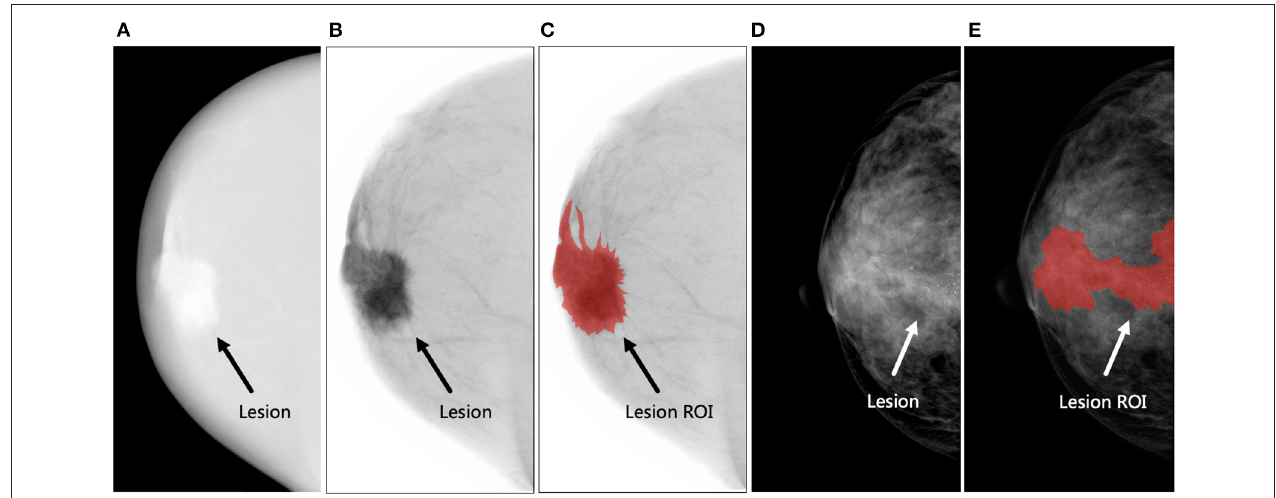
FIGURE 3 | Examples of lesion segmentation. (A–C) The figures demonstrate an irregular-shaped lesion (black arrow) in the retro-areolar region of the right breast of a 60-year-old woman. Biopsy revealed invasive ductal carcinoma (Grade II, Luminal A subtype). The region of interest (ROI) was delineated on the negative film of the high-energy (HE) image. (A) The original HE image, (B) negative film of HE image, and (C) delineated lesion ROI (shown in red). (D,E) The figures demonstrate a lesion (white arrow) presented as microcalcifications without corresponding mass in the central area of the right breast of a 47-year-old woman. Biopsy revealed invasive